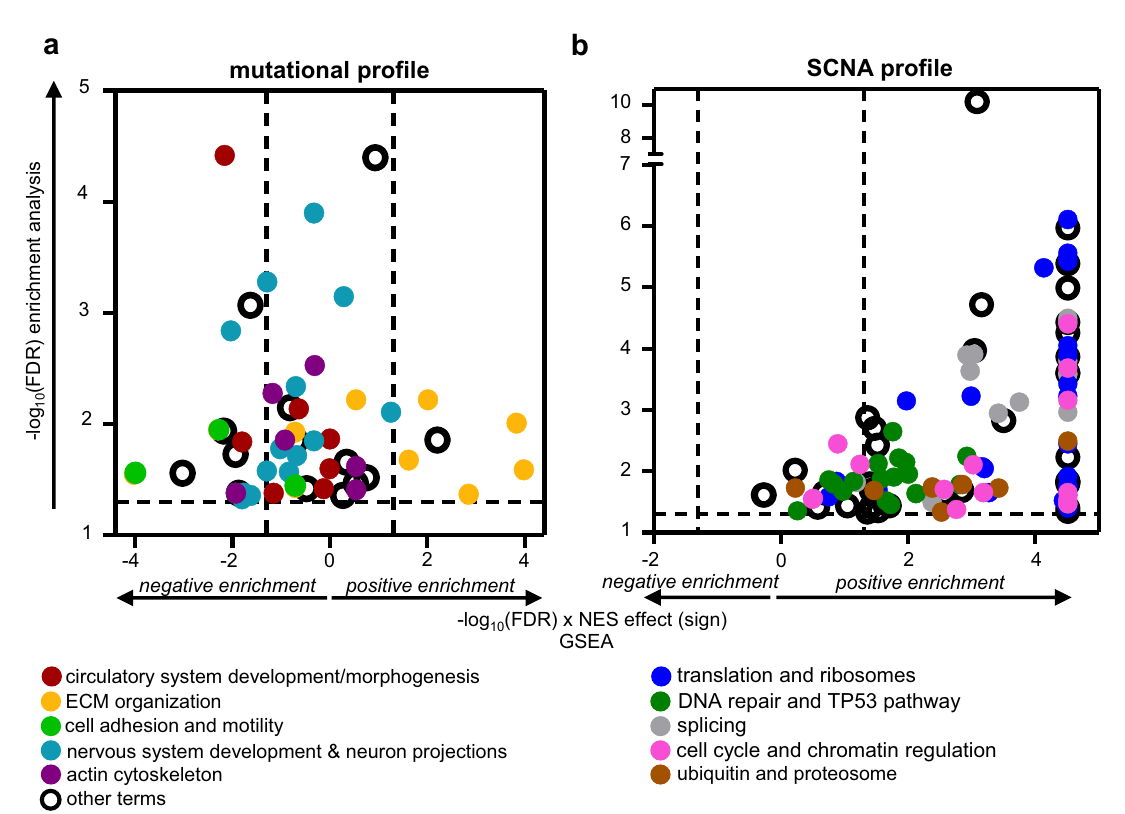
Fig. 5| Functionalenrichmentanalysisofmutated(a)andCN-altered (b)genes in mPPGLs. Functional enrichment analysis of mutated ( a ) and CN-altered ( b ) genes in mPPGLs. y -axis indicatesthe − log 10 (FDR)of eachgenesetidenti fi ed inthe functionalenrichmentanalysisperformedusingthelistof323genesmutatedinthe metastatic primary tumors ( a ) or the 911 genes with differing SCNA between metastatic and non-metastatic primary tumors ( b ). Only those gene sets with fold- change enrichment (FCe) > 1.8 and FDR<0.05 by Fisher ’ s Exact test were